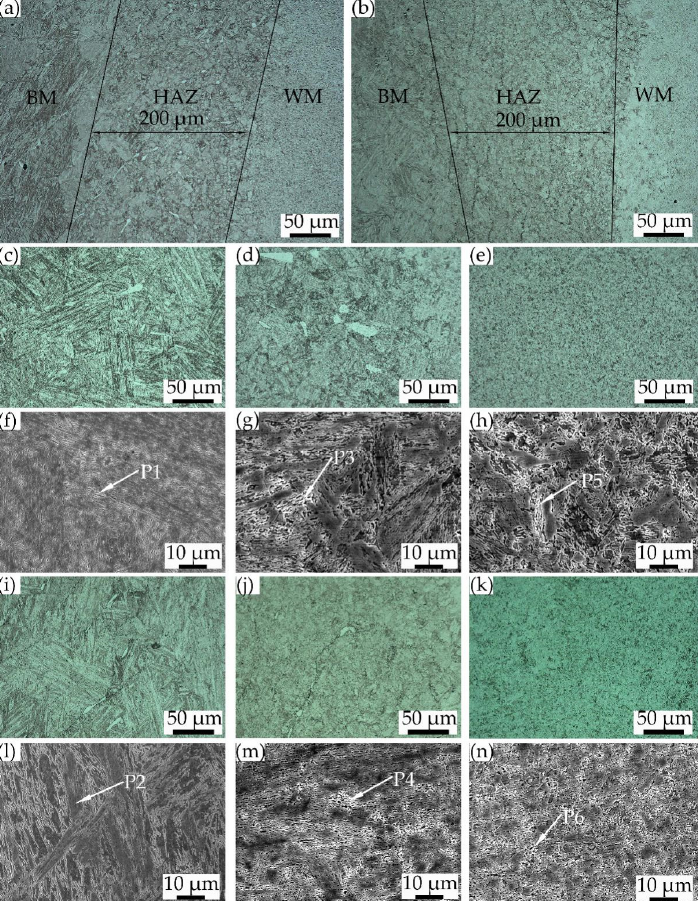
Figure 4. Microstructure of once and twice repair welded joints. ( a ) Once repair welded joint; ( b ) twice repair welded joint; ( c , f ) once repair welding BM; ( d , g ) twice repair welding BM; ( e , h ) once repair welding HAZ; ( i , l ) twice repair welding HAZ; ( j , m ) once repair welding WM; ( k , n ) twice repair welding WM. Table 2. Changes in Ni and Cr element contents in different regions (mass fraction, wt.%). Element P1 P2 P3 P4 P5 P6 Cr/wt.% 12.69